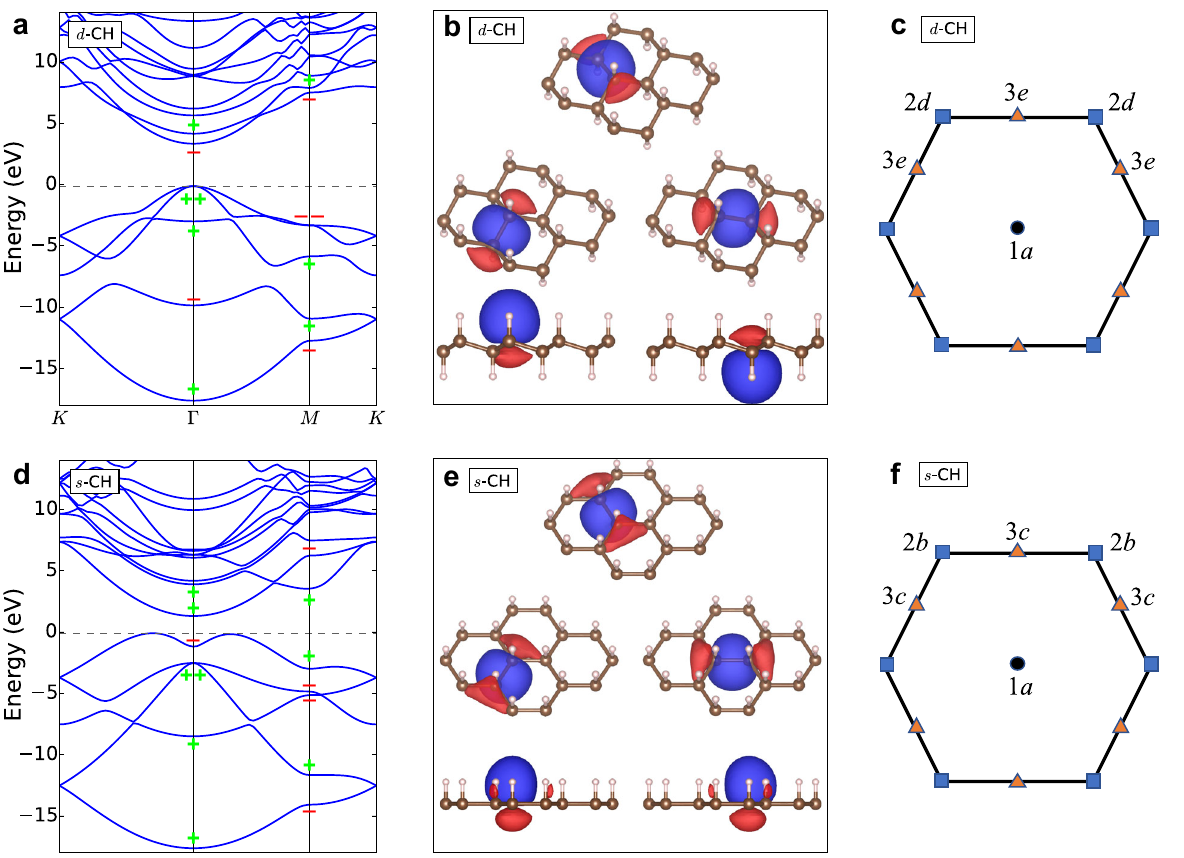
Fig. 2 Electronic structure analysis of hydrogenated graphene. Band structure of a d -CH and d s -CH. ± marks Bloch states having opposite parities with respect to inversion or C 2 z operation at high-symmetry points of the Brillouin zone. Isosurface contours of maximally localized Wannier functions (MLWFs) constructed from the fi ve valence bands of b d -CH and e s -CH, displaying the character of σ -bonded combinations of sp 3 hybrids (blue for positive value and red for negative). Wyckoff positions for c d -CH with space group 164 and f s -CH with space group 183. The main Wyckoff sites are indicated by a black dot, blue squares (C atoms) and orange triangles (empty sites), respectively.